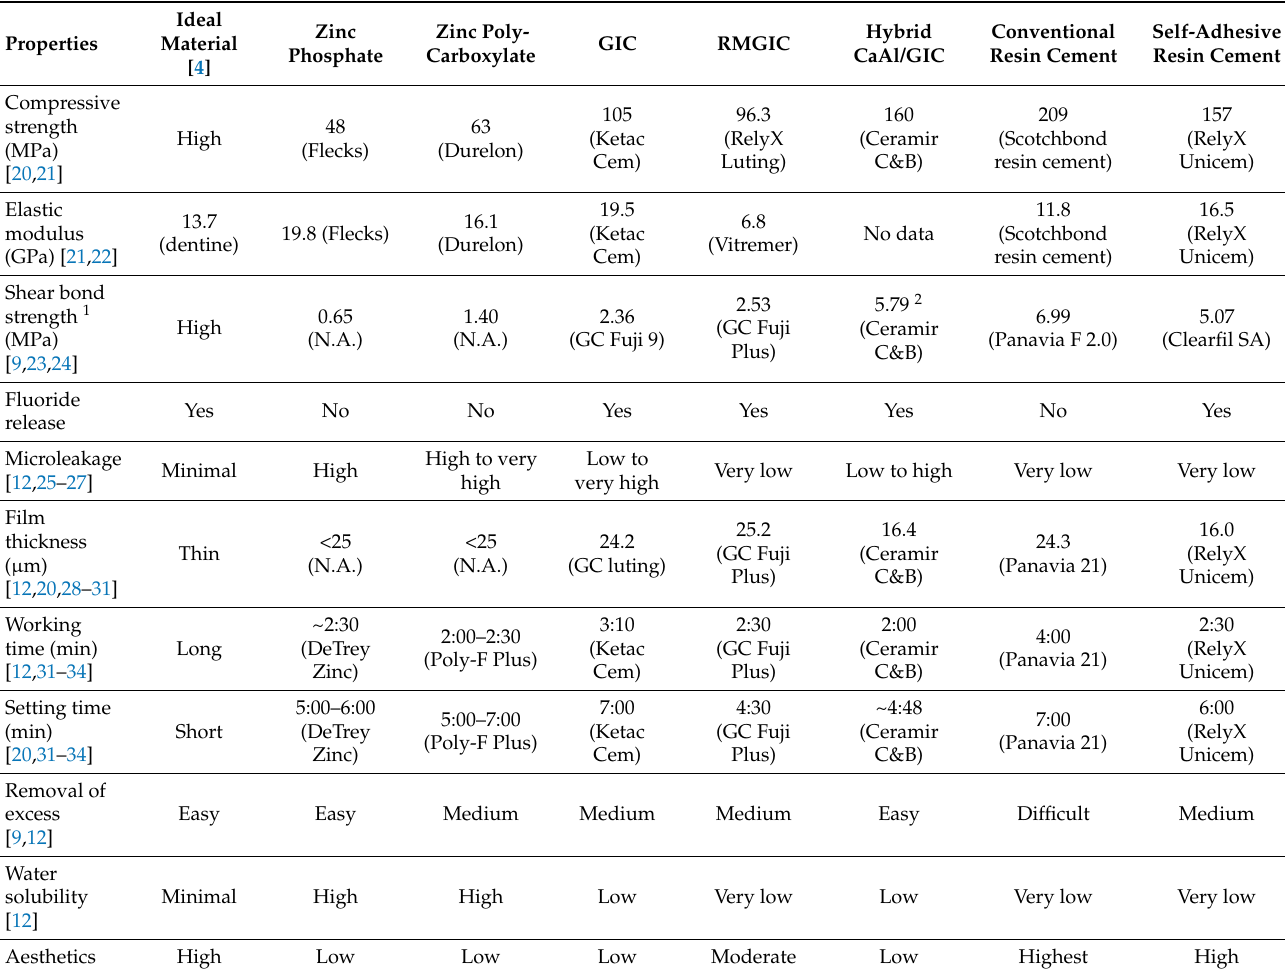
Table 2. Properties and permanent luting